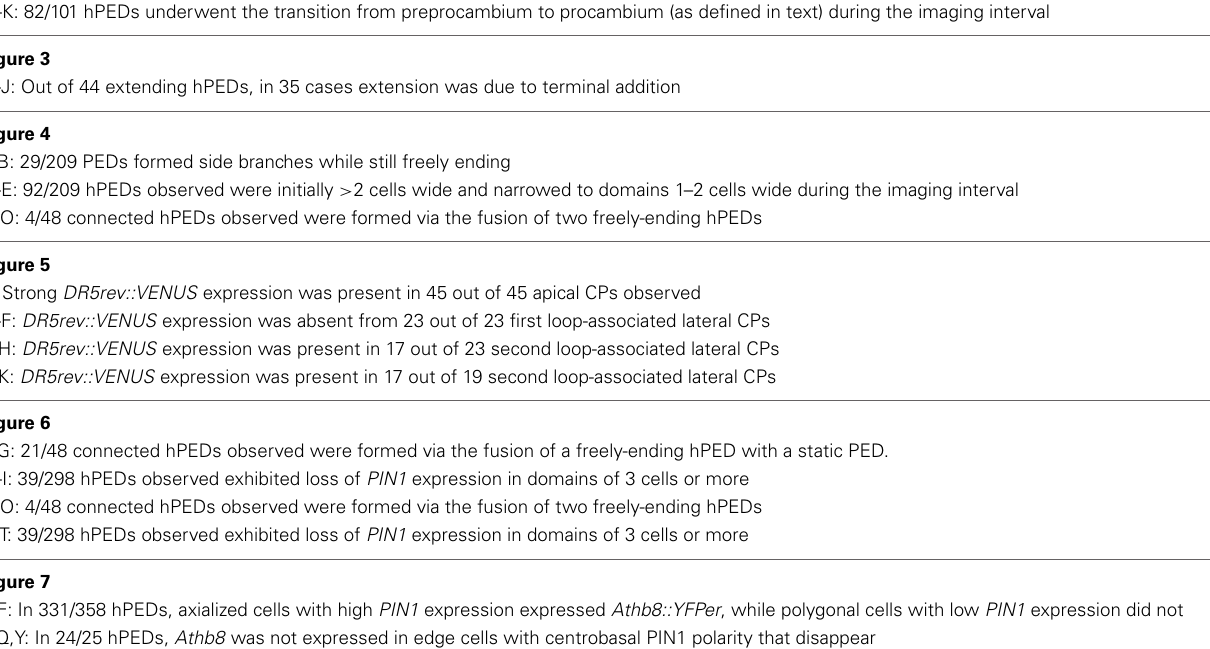
Table 2 | Features used as criteria in the calculation of reproducibility